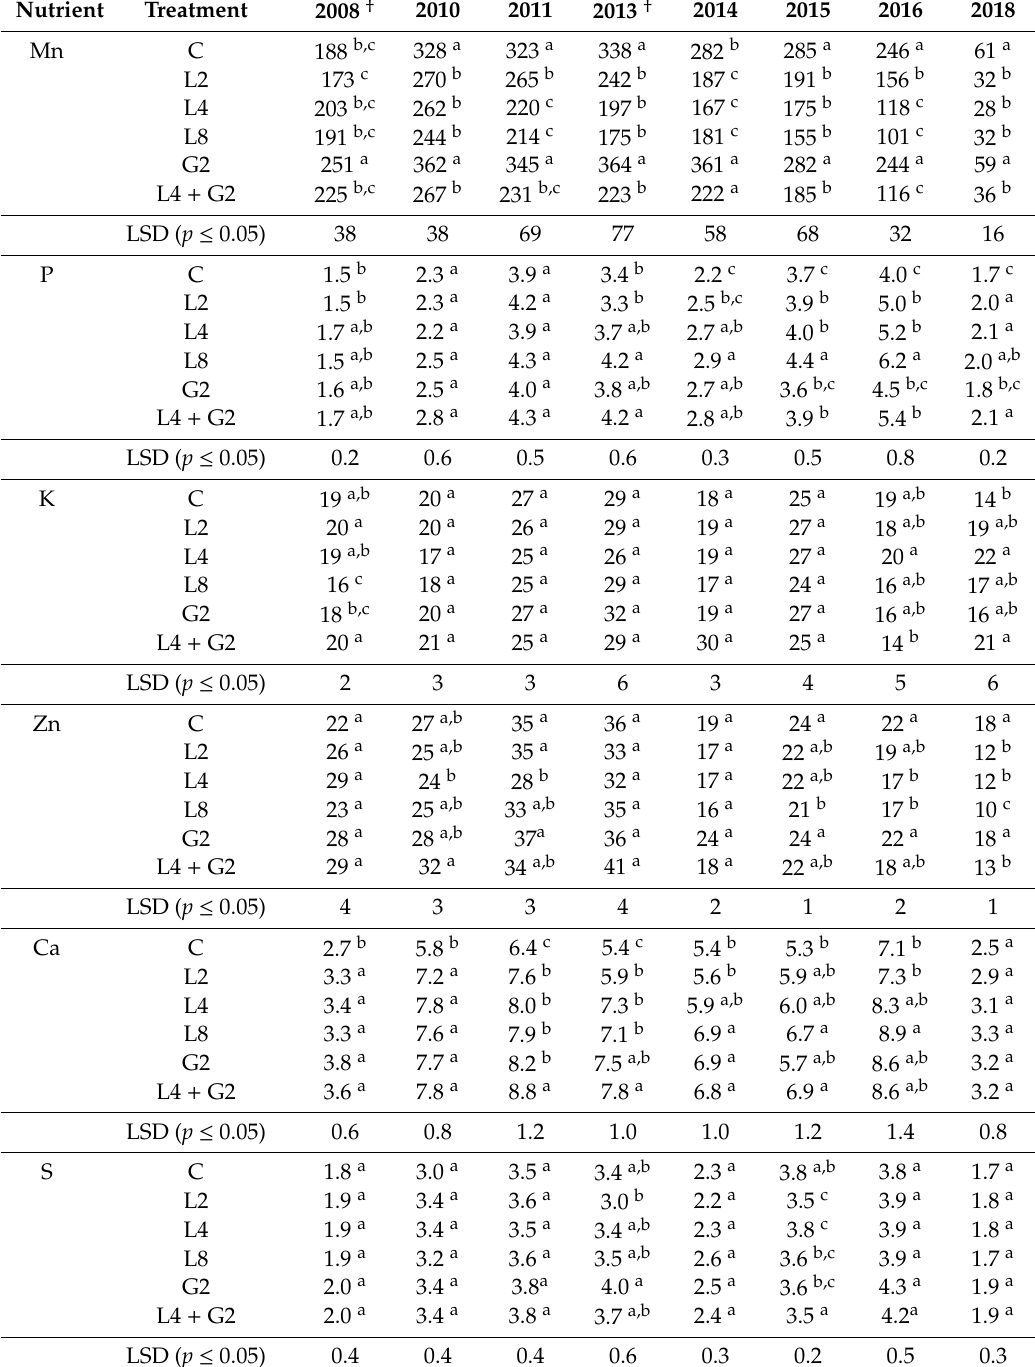
Table 7. Wheat shoot Mn (mg kg − 1 ), P (g kg − 1 ), K (g kg − 1 ), Zn (mg kg − 1 ), Ca (g kg − 1 ), and S (g kg − 1 ) measured at the LT experiment among years for the treatments control (C), 2 t L ha − 1 (L2), 4 t L ha −